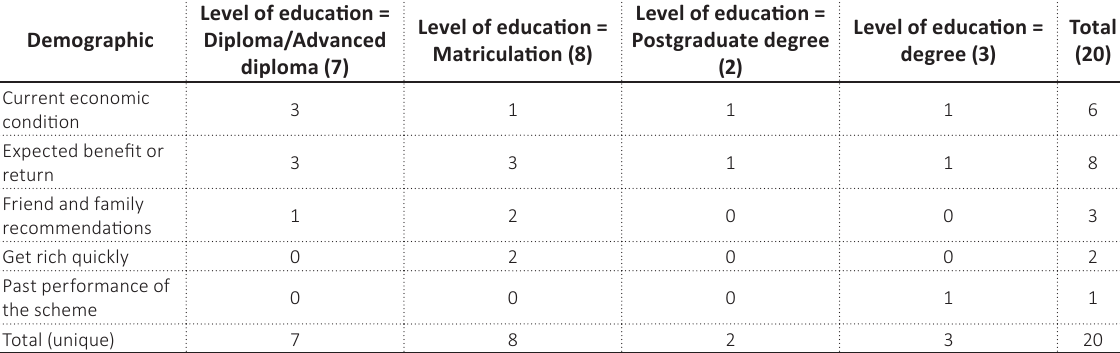
Table 4. Comparison of the level of education and factors leading to the uptake of pyramid schemes